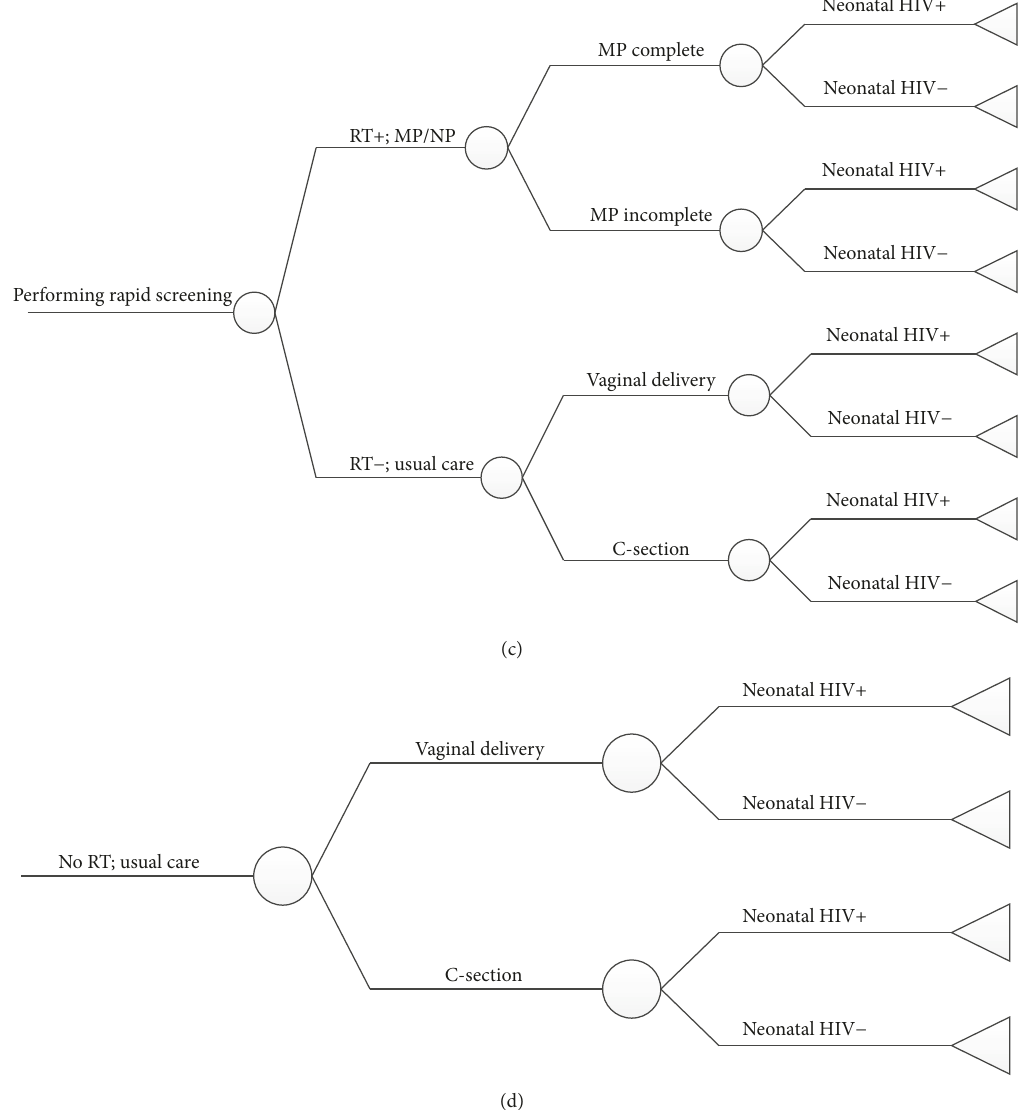
Figure 1: Simplified depiction of decision-treeused fortheanalysis. (a) Threestrategies, universal rapid HIVscreening, standardof care I, and standard of care II, are compared in the analysis. (b) Scenarios based on prenatal HIV screening and the screening result. (For simplicity, the figure assumes 100% sensitivity and 100% specificity for the prenatal HIV screening.) (c) The care pattern for patients undergoing intrapartum rapid screening. (d) The care pattern for patients not undergoing intrapartum rapid screening. US: universal screening; SC1, standard of care I; SC2, standard of care II; RS, rapid screen; UC, usual care; MP, maternal prophylaxis; NP, neonatal prophylaxis; T1, first trimester; T3, third